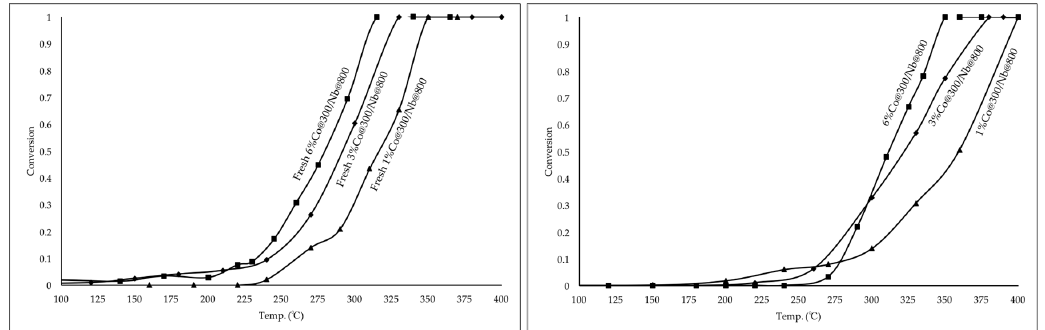
Figure 4 . Fresh Co@300/Nb@800 with loadings of 1%, 3%, and 6%, for propane oxidation (left); aged Figure 4. Fresh Co@300/Nb@800 with loadings of 1%, 3%, and 6%, for propane oxidation ( left ); aged